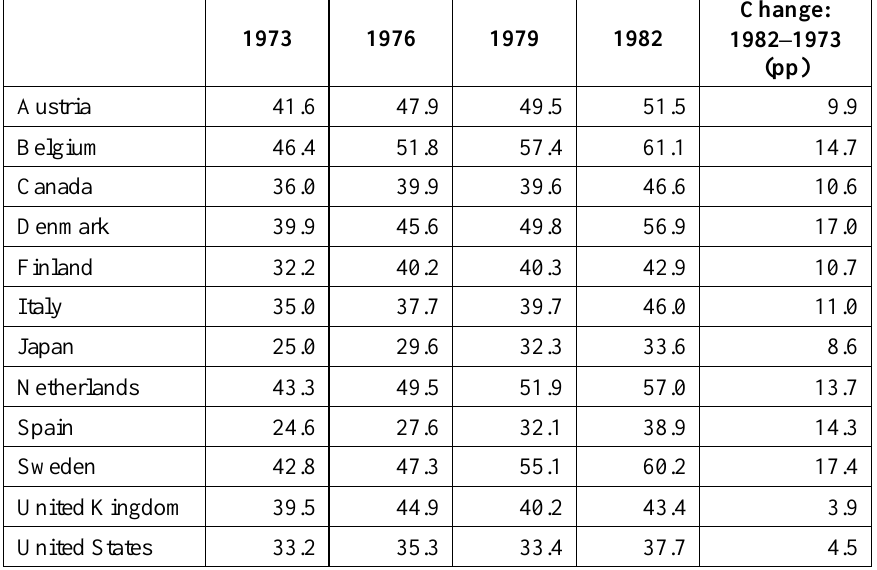
Table 1. Public expenditure (% of GDP) in twelve OECD member countries, 1973–1982 (OECD,